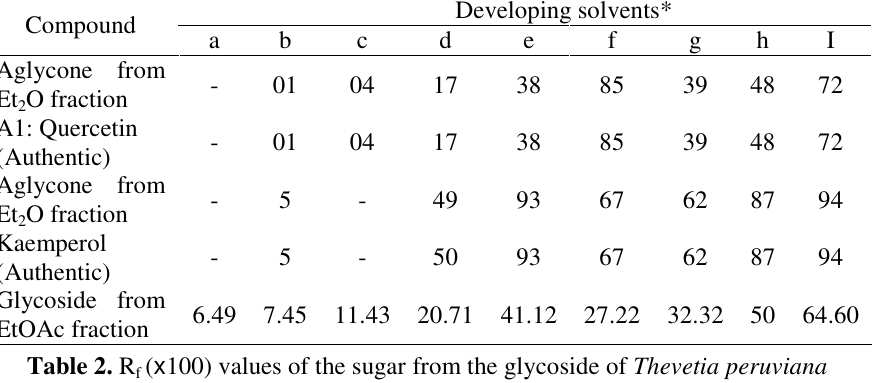
Developing solvents*